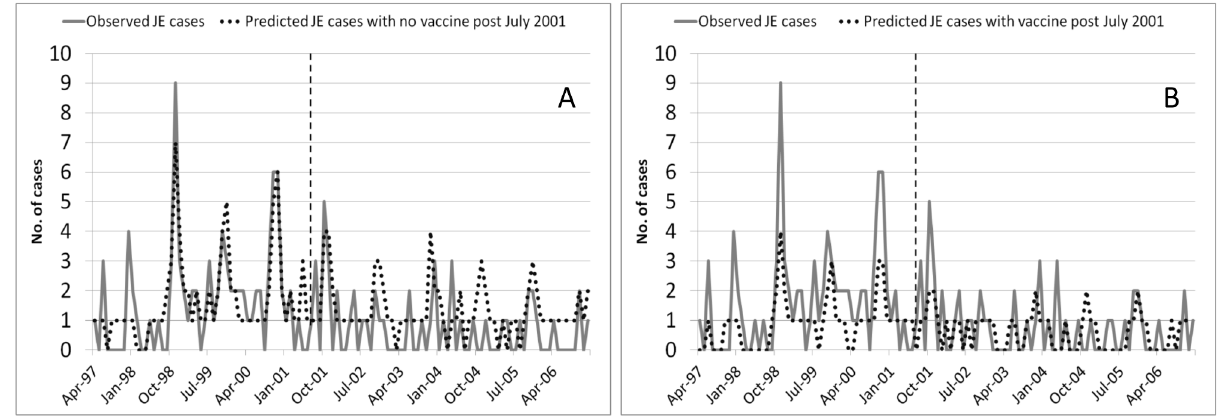
Figure 3. Observed versus predicted JE cases (A) without and (B) with vaccine coverage over the 10-year surveillance period: the vertical grey dotted line represents the introduction of the JE vaccine into the National Immunization program in Sarawak, Malaysia in July 2001. A– Predicted JE cases modelled without vaccine coverage over the 10-year period, minimum temperature at 6-months lag, rainfall at 1-month lag, SOI at 6-months lag and modelled seasonality. B– Predicted JE cases modelled with vaccine coverage throughout the 10-year surveillance period, minimum temperature at 6-months lag, rainfall at 1-month lag, SOI at 6-months lag and modelled seasonality).